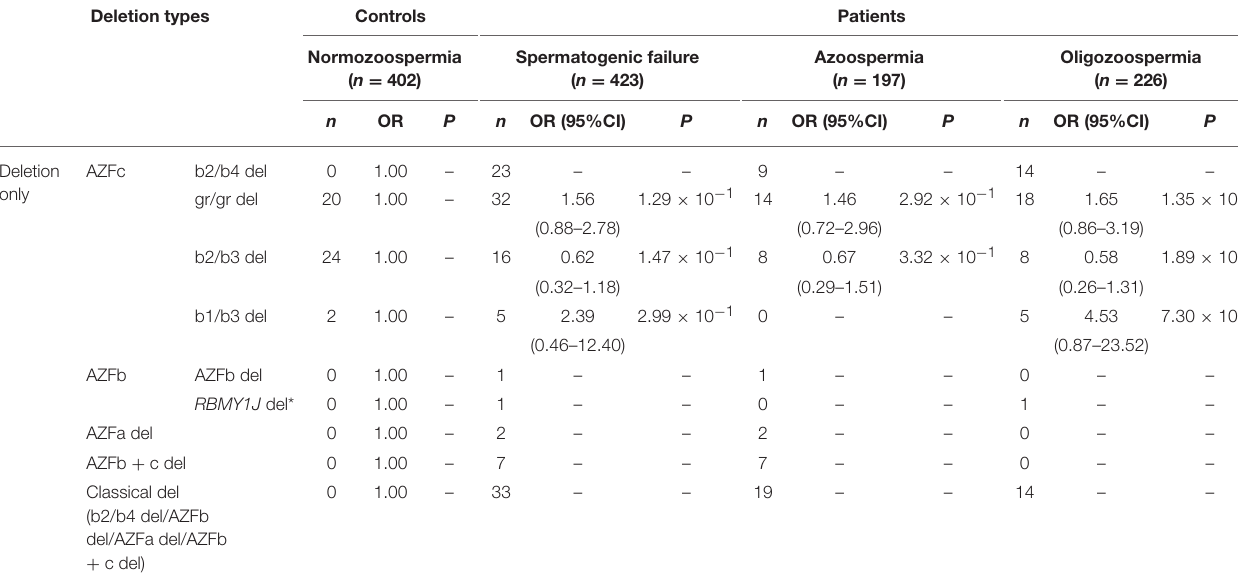
TABLE 2 | Distribution of known and novel deletions in AZF regions and their effects on SF. Deletion types